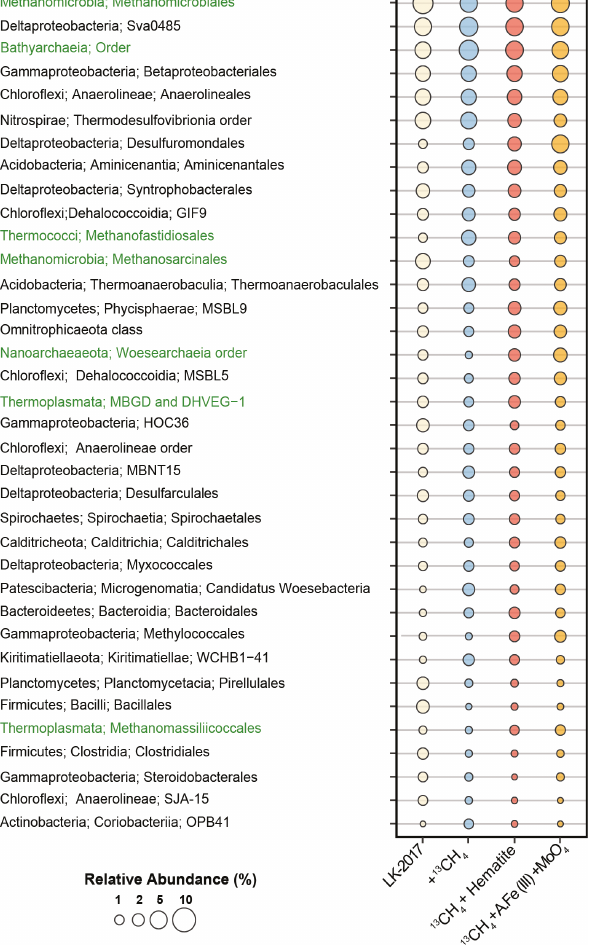
Figure 1. Relative abundance of bacteria (black) and archaea (green) at the order level based on mapping of metagenomic reads to the Silva 132 database of the small subunit rRNA sequences. Lin- eages < 1%, which account together for 28–32% of the microbial community, were removed from the display. LK 2017 refers to the natural sediments at depth 26cm at